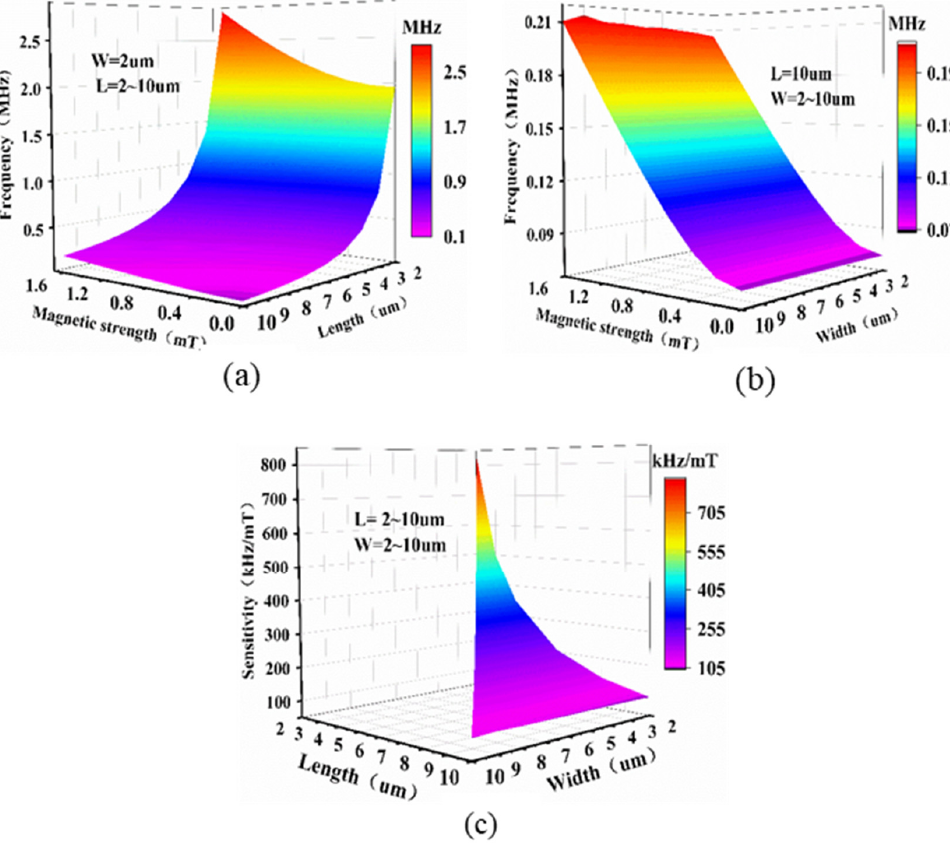
Figure 6. Resonance frequency versus magnetic field as a function of ( a ) length, and ( b ) width. ( c ) Sensitivity of beam as a function of length and width.